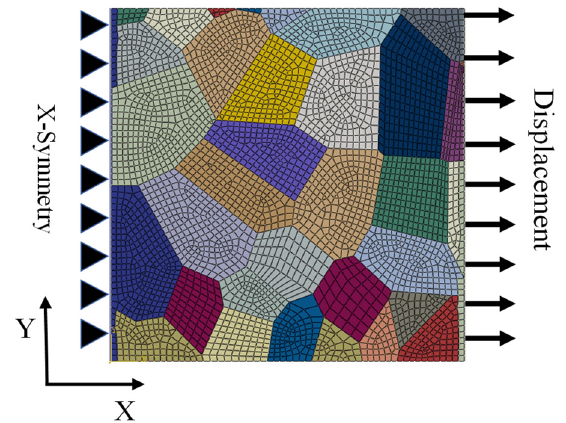
Figure 4. Voronoi grid diagram and boundary conditions simulated by tensile test.